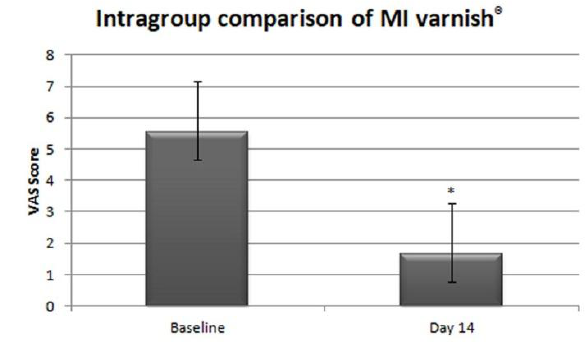
Figure 2 : Intragroup comparison at baseline and at 14th day (Fluoritrop SR®). VAS Score is expressed as mean±SD. *p <